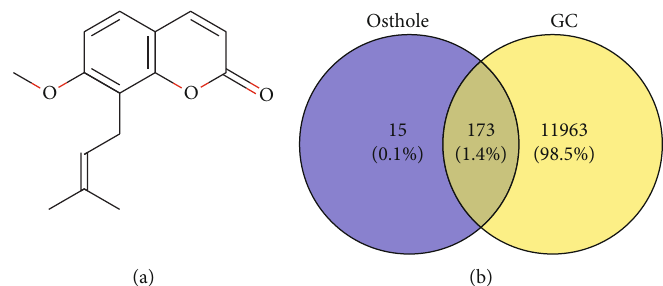
Figure 2: (a) The chemical structure of osthole. (b) Venn diagram of potential targets of osthole in the treatment of